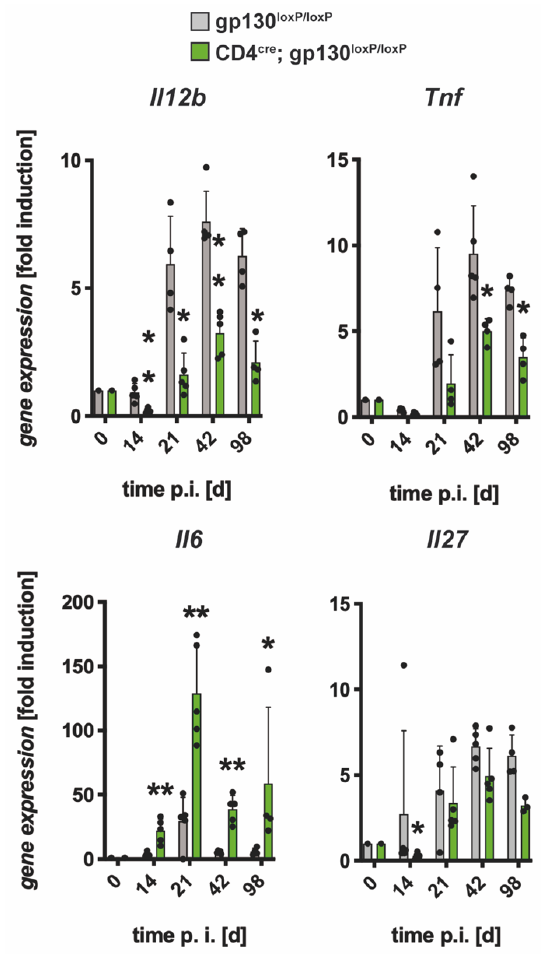
Figure 4. Cytokine gene expression in the lungs of Mtb-infected CD4 cre ; gp130 loxP/loxP mice. gp130 loxP/loxP (grey symbols) and CD4 cre ; gp130 loxP/loxP mice (green symbols) were infected with approximately 100 CFU Mtb via the aerosol route. Lung RNA was isolated at the indicated time points. After reverse transcription, expression of Il12b , Tnf , Il6 and Il27 was quantified by real-time RT-PCR based on gene expression in uninfected mice. Mean values with standard deviations of 5 mice per group are shown. One representative experiment of two is shown. Data were statistically